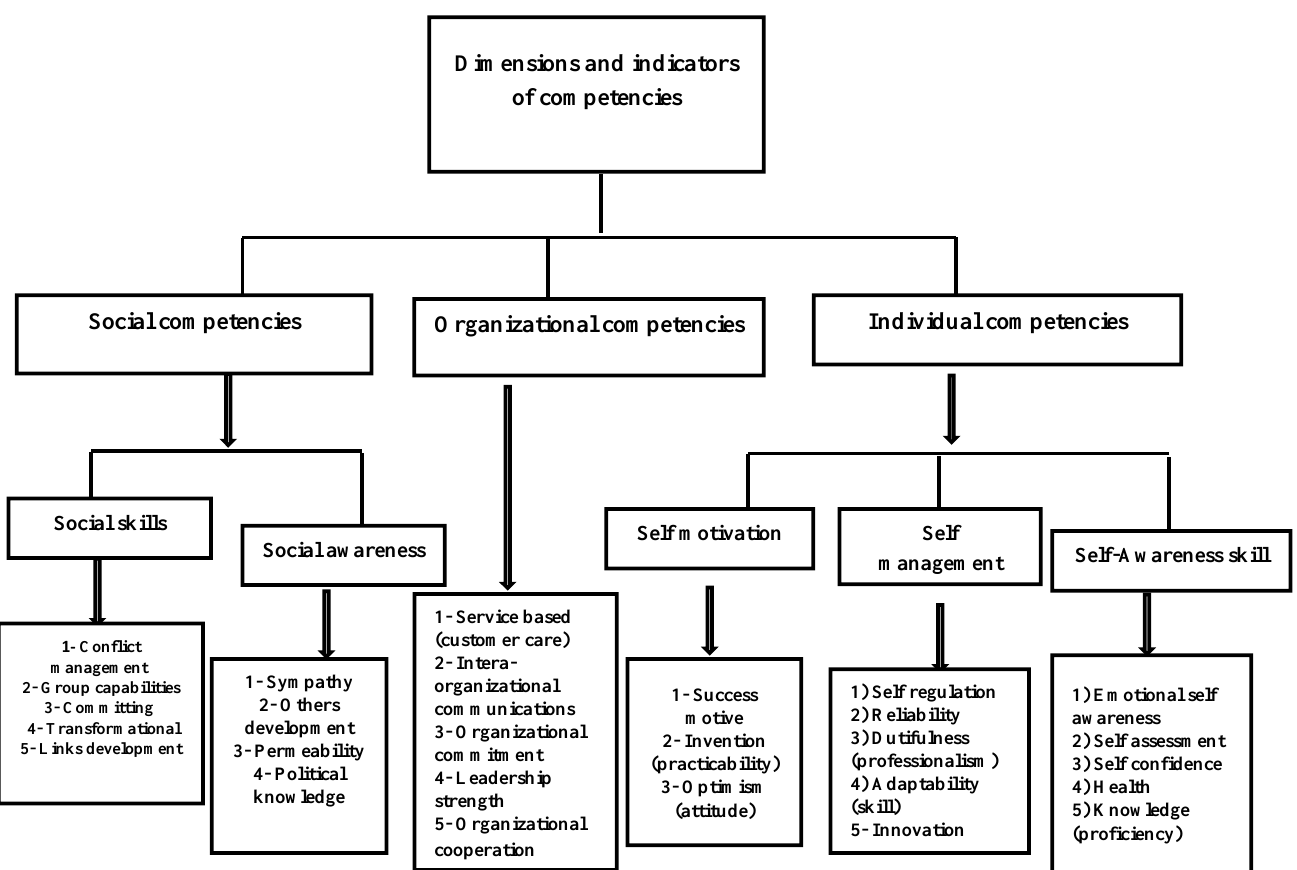
Fig. 1. Indicators of individual, organizational and social